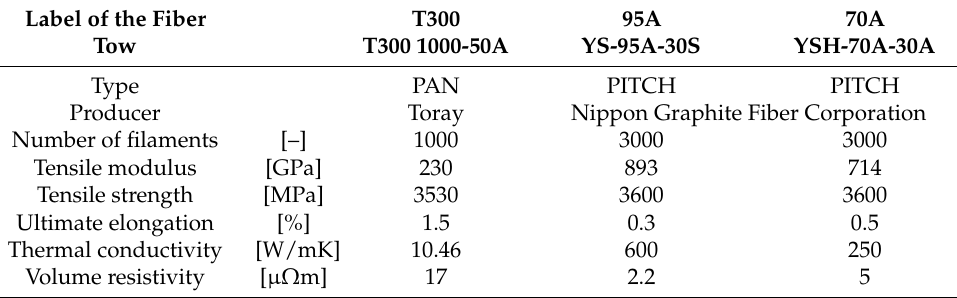
Table 2. An overview of the carbon fiber tows examined